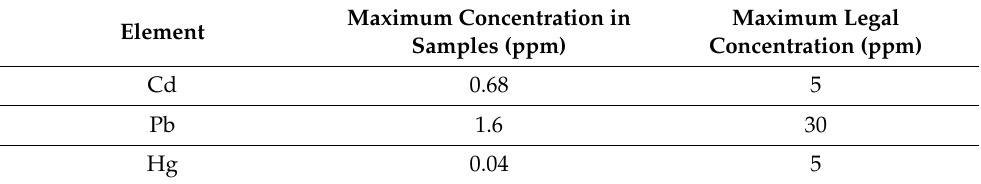
Table 4. Concentration of heavy metals in samples. Maximum Concentration Element